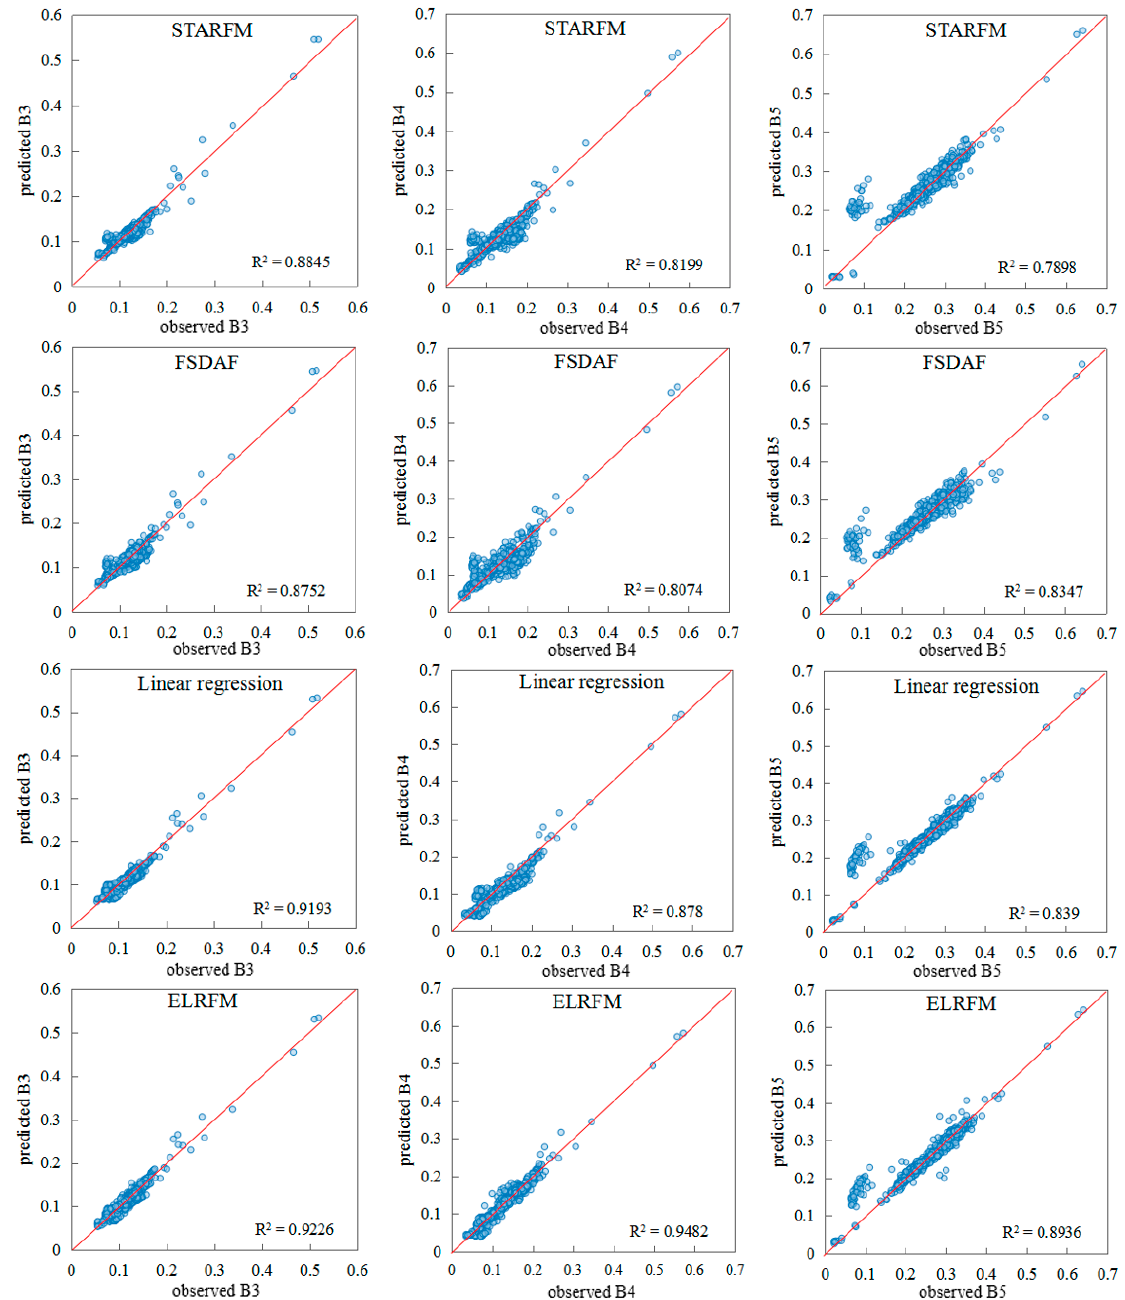
Figure 6. Scatter plots of the observed and predicted reflectance from the four fusion methods in the green (B3), red (B4), and near-infrared (B5) bands.